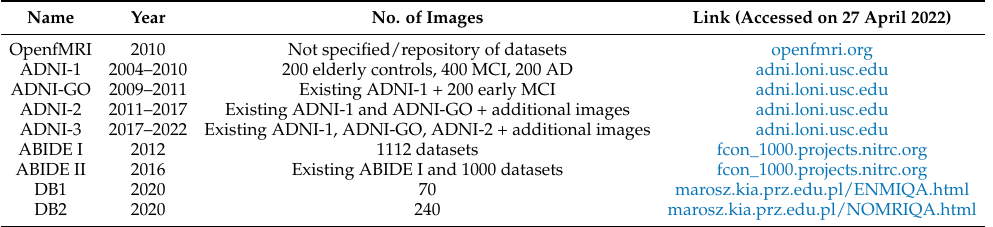
Table 2. Details of the MR image